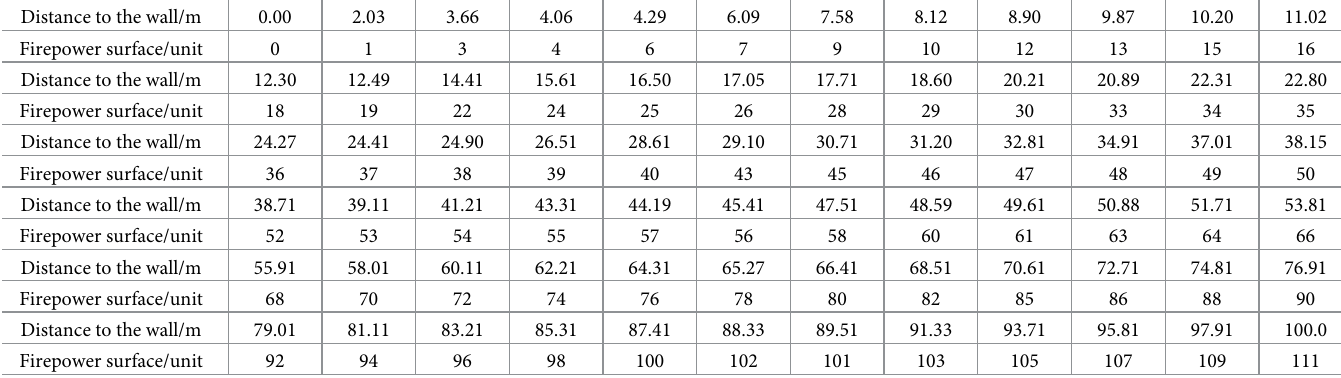
Table 2. Calculation of the firepower value of the space under the south wall of Puzhuang Suo-Fort. Distance to the wall/m